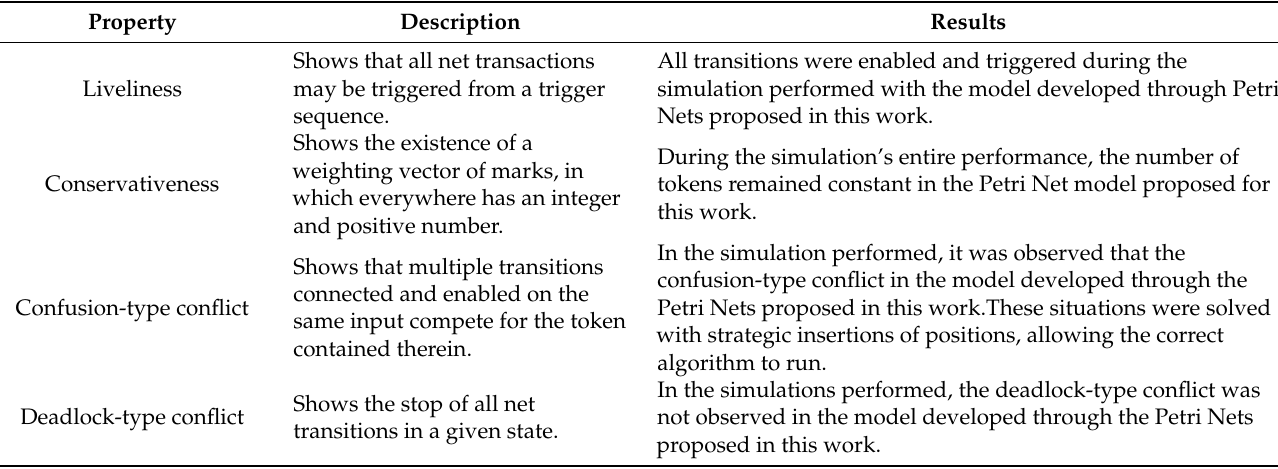
Table 3. Property